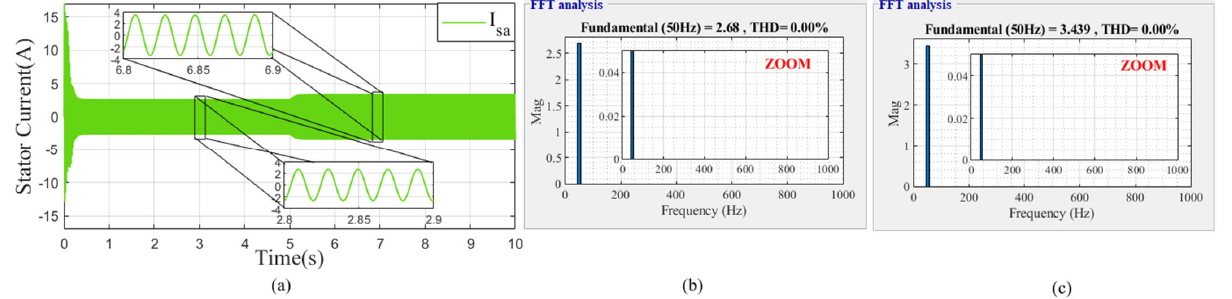
Figure 18. Performance with Cage bearing defect of IM without control: ( a ) rotation speed and ( b ) motor torque.